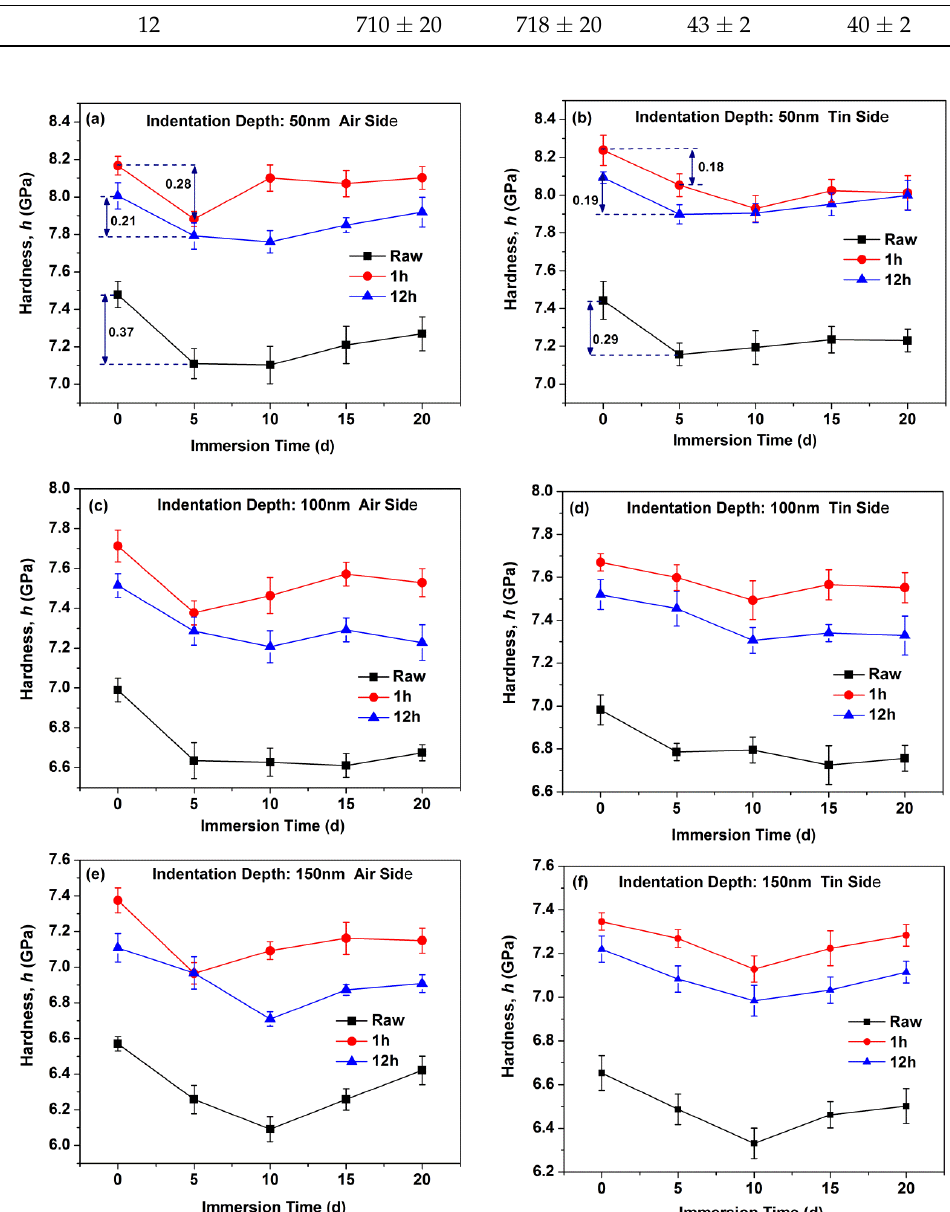
Figure 3. Hardness as a function of the immersion time on the air side at indentation depth of 50 nm ( a ), on the tin side at indentation depth of 50 nm ( b ), on the air side at indentation depth of 100 nm ( c ), on the tin side at indentation depth of 100 nm ( d ), on the air side at indentation depth of 150 nm ( e ), and on the tin side at indentation depth of 150 nm ( f ).